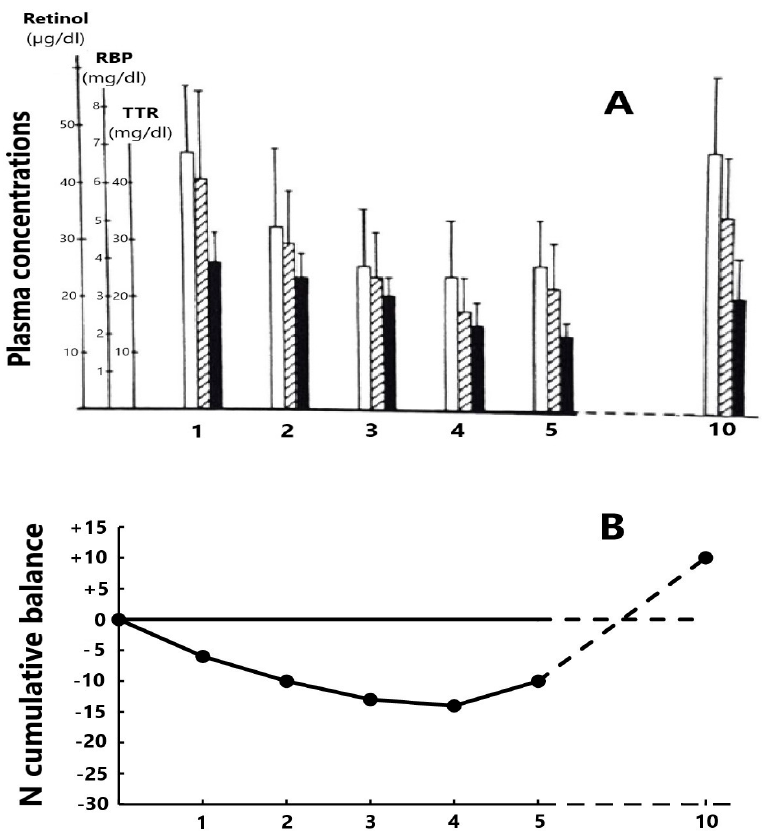
Figure 1. Evolutionary patterns of the RCC edifice during a depletion period following a stress of medium severity. ( A ) The 3 components of the RCC measured in 15 healthy adult hysterectomized females [84] maintain close relationships during the post-operative period ( □ retinol, RBP and ■ TTR). The nadir level is reached on days 4–5 and, in the absence of complications, healing is recorded on day 10 with full restoration of basal RCC values. ( B ) The cumulative mean N balance in 28 healthy adult subjects undergoing abdominal surgery and who were enterally refed [85]. Urinary excretion of nitrogenous compounds is mainly due to the cytokine-induced breakdown of tissue proteins stored in lean body mass (LBM) whose depletion may be quantified by TTR values showing the same declining profile as that of N.